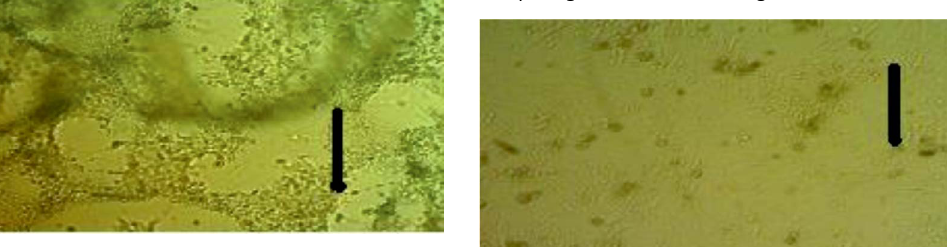
Fig 2. Tissue culture of fetal calves’ kidney that infected with Influenza virus after 48 hours. TCID50 of the virus 10 3.5 virus/ ml (positive control)